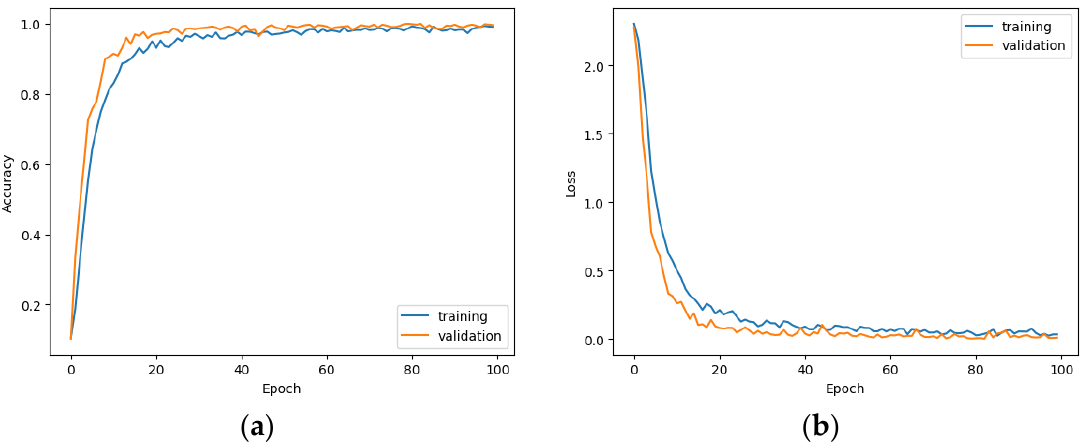
Figure 13. Accuracy ( a ) and loss ( b ) in relation to the number of epochs.